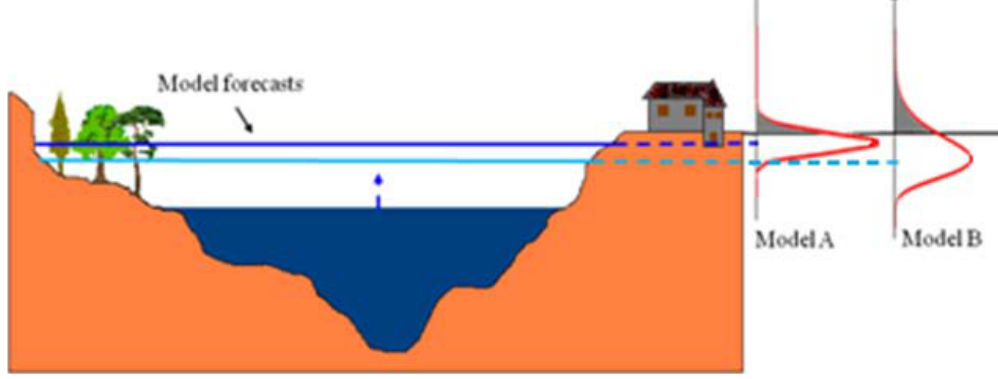
Fig. 2. Comparison between the expected value provided by models with different reliability when the probability of exceeding the dyke level is the same for all the